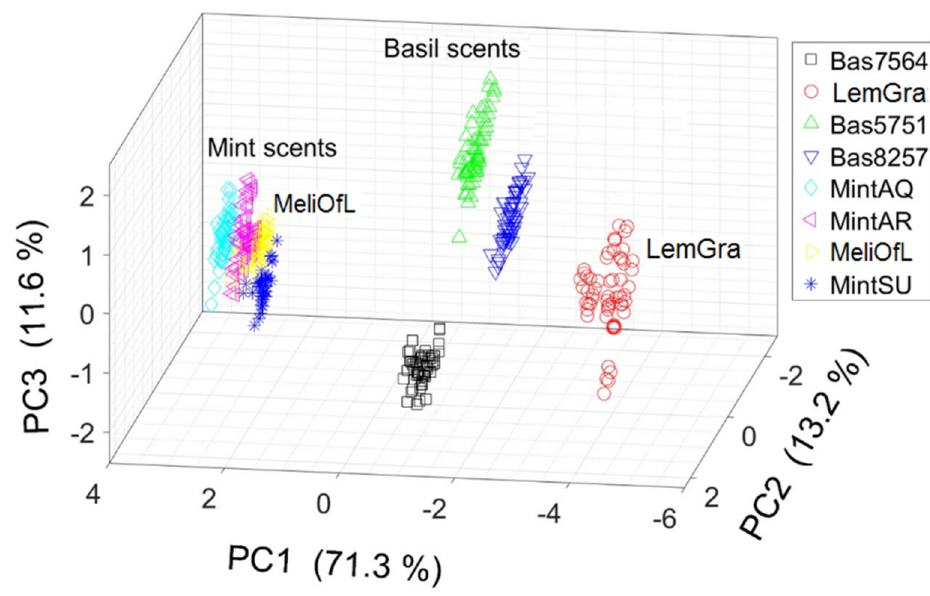
Figure 6. Three-dimensional plot of the principal component coefficients from 451 observations.